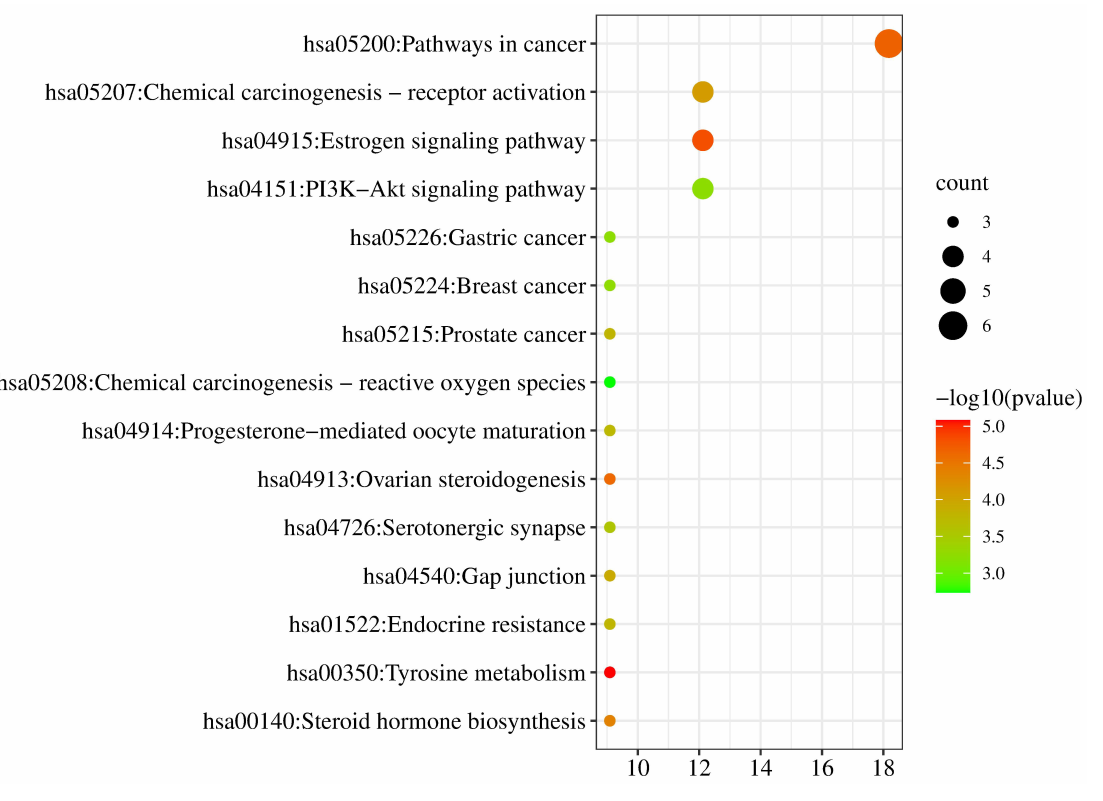
Figure 11. KEGG analysis of the target proteins of neobavaisoflavone.